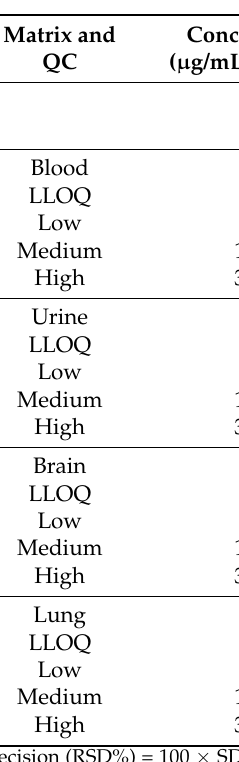
Table 1. Equations and correlation coefficients (r 2 ) for all the matrices tested are reported. Mean and standard deviation (SD) are calculated over five calibration curves. Table 2. Precision and accuracy of the sevoflurane